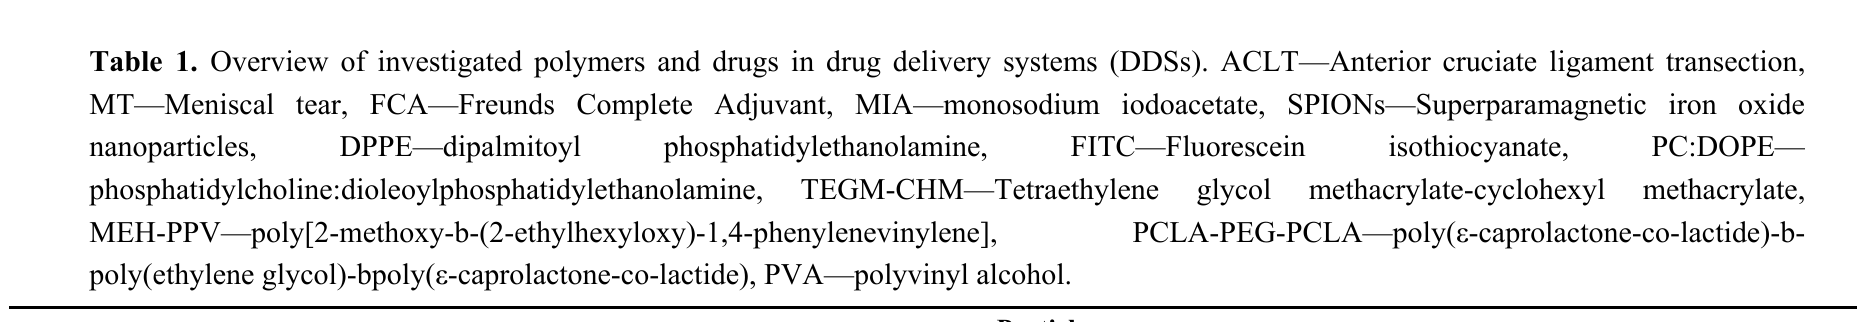
Table 1. Overview of investigated polymers and drugs in drug delivery systems (DDSs). ACLT—Anterior cruciate ligament